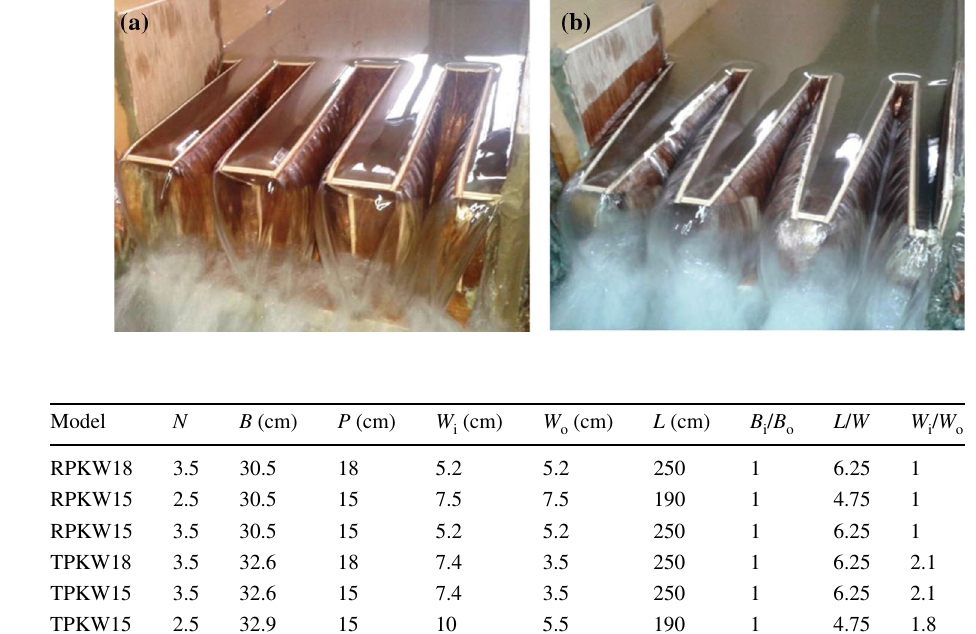
Fig. 4 Flow over a rectangular, and b trapezoidal PKW